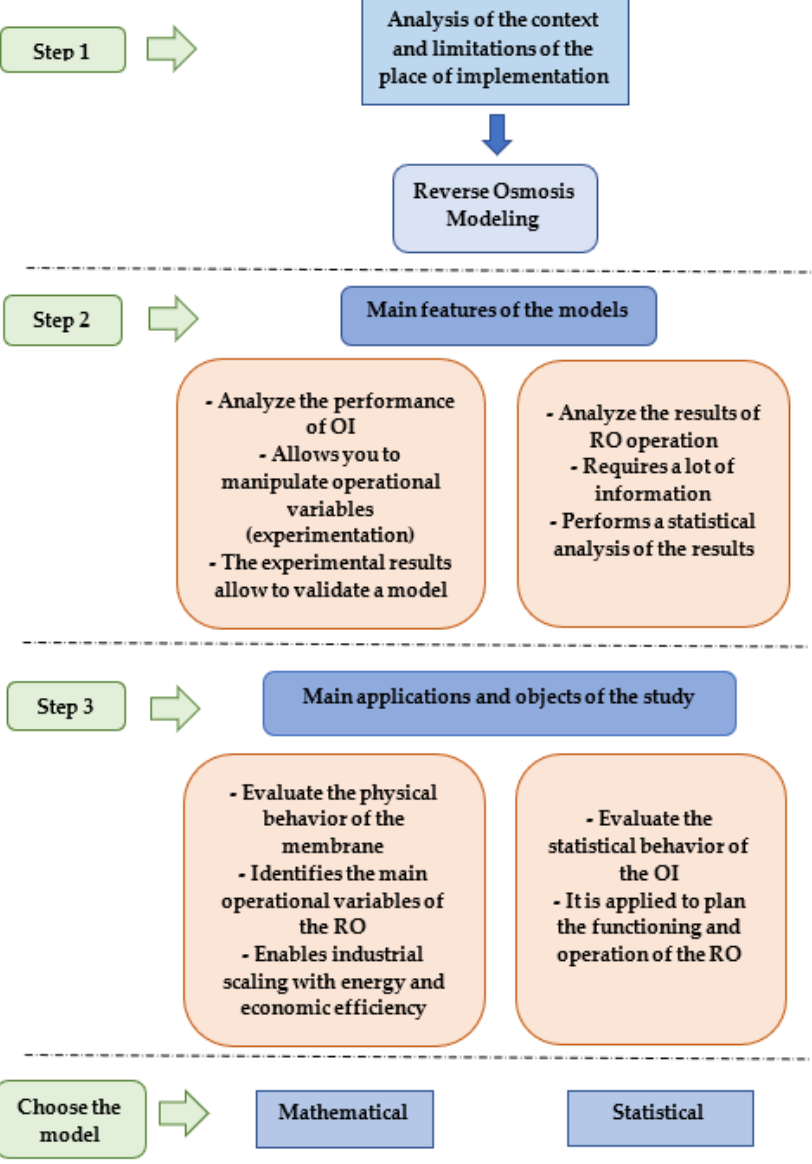
Figure 7. Schematic procedure to define the ideal model.